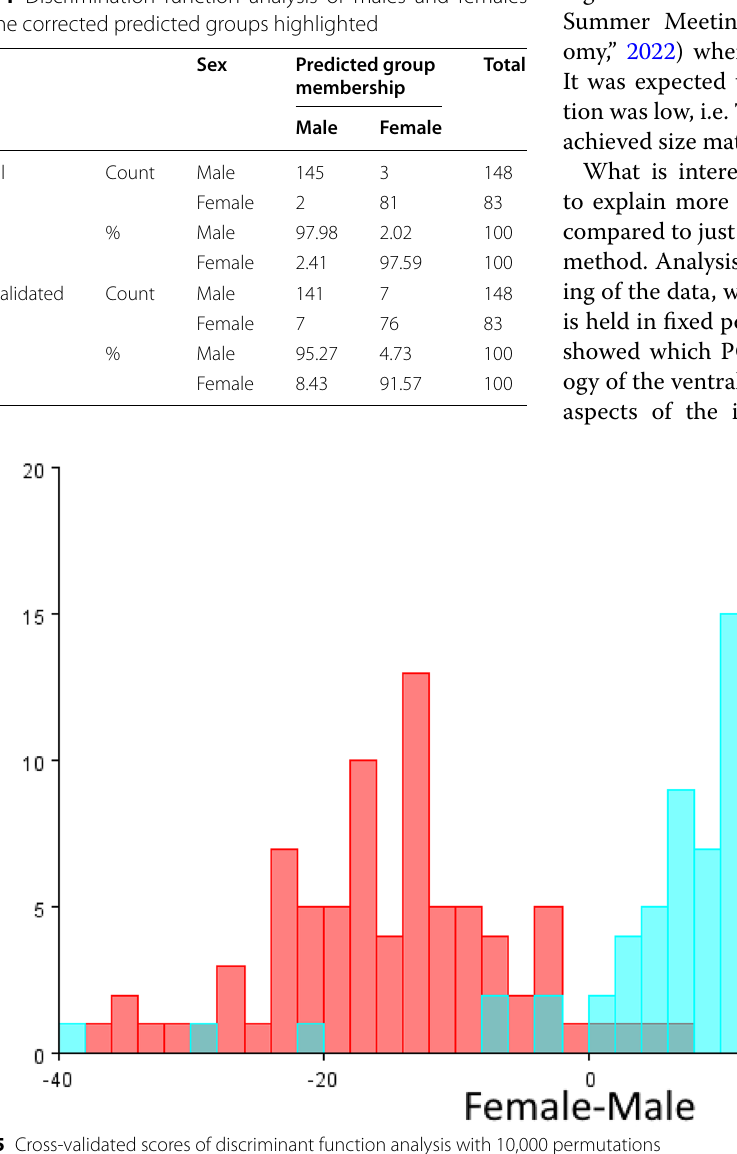
Fig. 5 Cross-validated scores of discriminant function analysis with 10,000